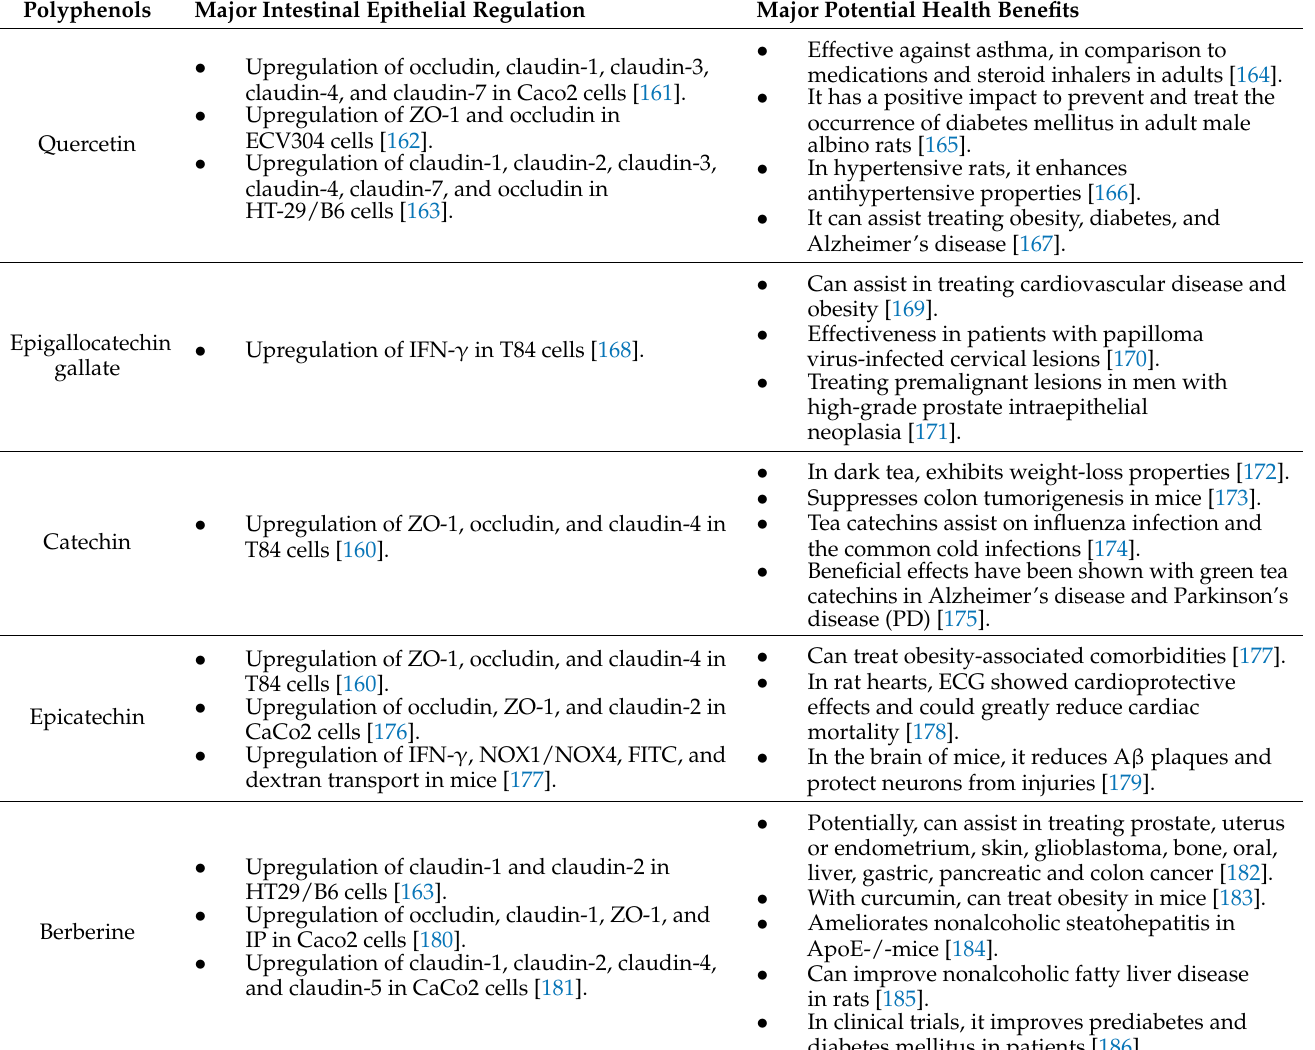
Table 2. Major polyphenols that help leaky